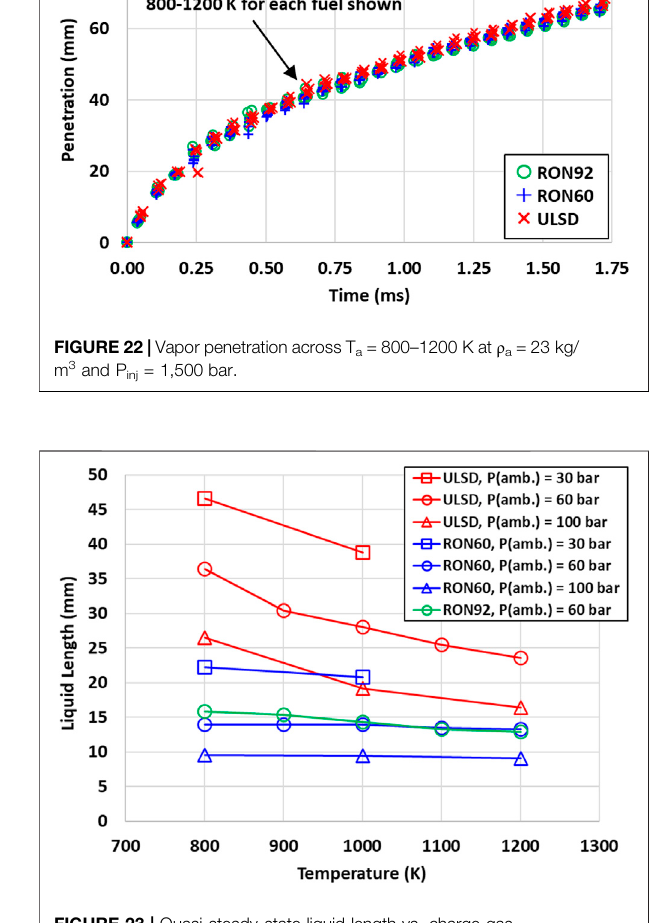
FIGURE 23 | Quasi-steady-state liquid length vs. charge gas temperature at P inj = 1,500 bar and different charge gas